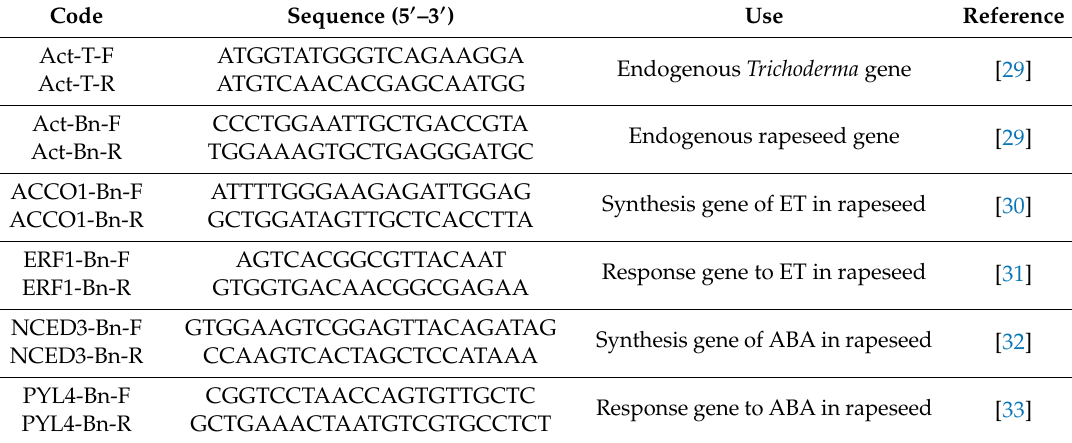
Table 1. Oligonucleotides used in this